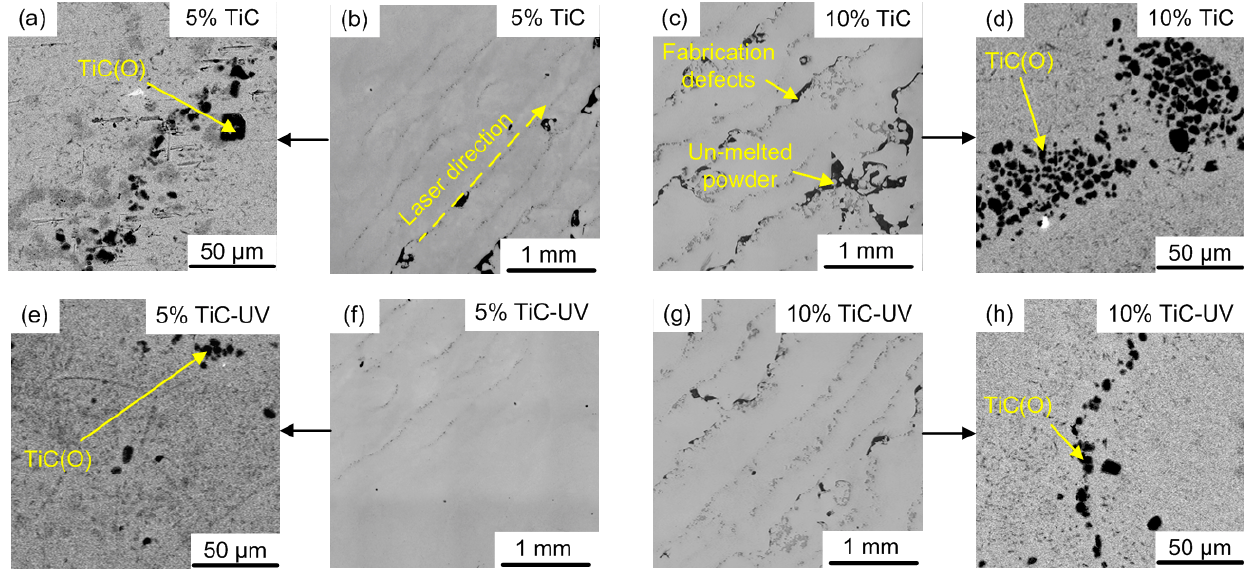
Figure 5. The microstructure of a laser DED fabricated TiC-TMC coating: ( a , d , e , h ) the SEM images; ( b , c , f , g ) the OM images. As shown in Figure 5c,g, with the increase of TiC content, more TiC(O) particles aggregated in the LDED fabricated coatings. As discussed in Section 3.1, the TiC-TMC coatings with a higher content of TiC had more TiC(O) particles. The larger amount of solid TiC(O) particles could reduce the fluidity of the molten pool, which suppressed the movement of solid TiC(O) particles [39]. In addition, the specific heat capacity and laser absorptivity of TiC and Ti were different. The increase of the TiC content could enlarge the difference of the temperature and solidification rates inside the molten pool [40]. In the regions with a low temperature, liquid materials solidified faster. It could also suppress the movement of solid TiC(O) particles and resulted in the variation of the distribution of TiC(O)